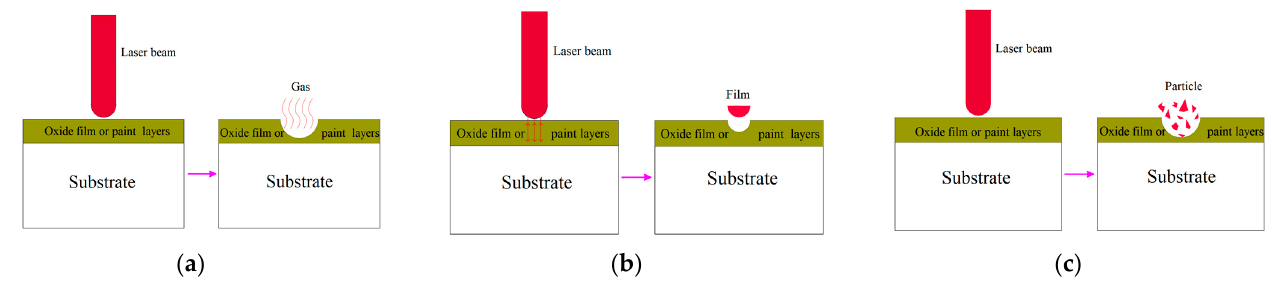
Figure 1. The mechanism of laser cleaning. ( a ) ablation gasification; ( b ) vibration stripping; ( c ) ex- plosion stripping. ( c ) explosion